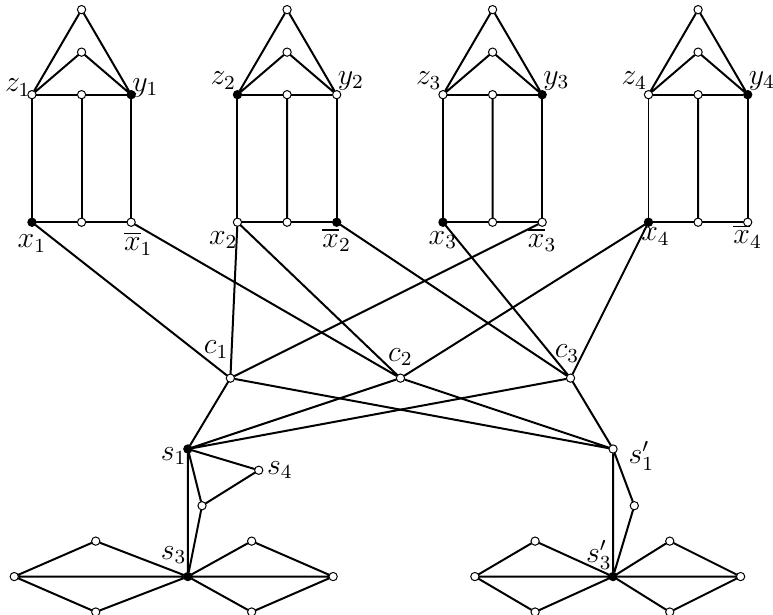
Figure 2: An instance of the restrained reinforcement number problem resulting from an instance of 3-SAT. Here k = 1 and γ ( G ) = 11, where the black vertex p means there is a r RD-set D containing p